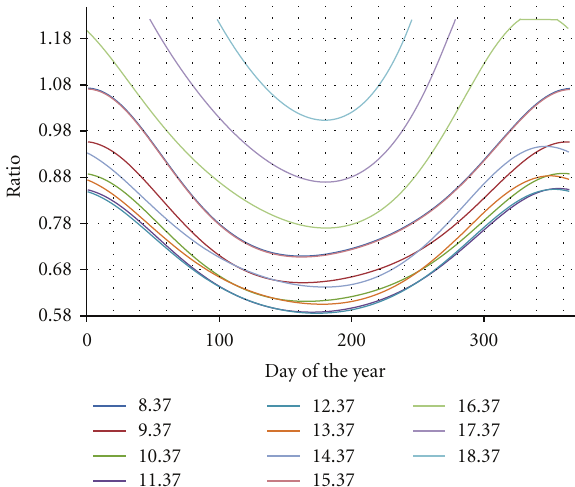
Figure 12: Ratio values of mirror 6 along the year (one-hour steps).